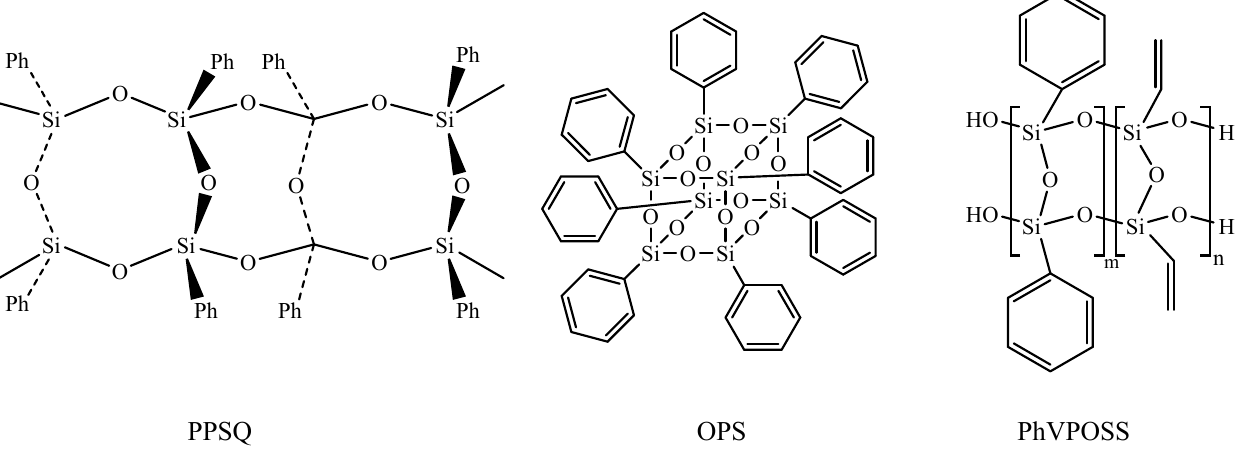
Figure 1. PPSQ, OPS and PhVPOSS, silsesquioxanes with different structures.